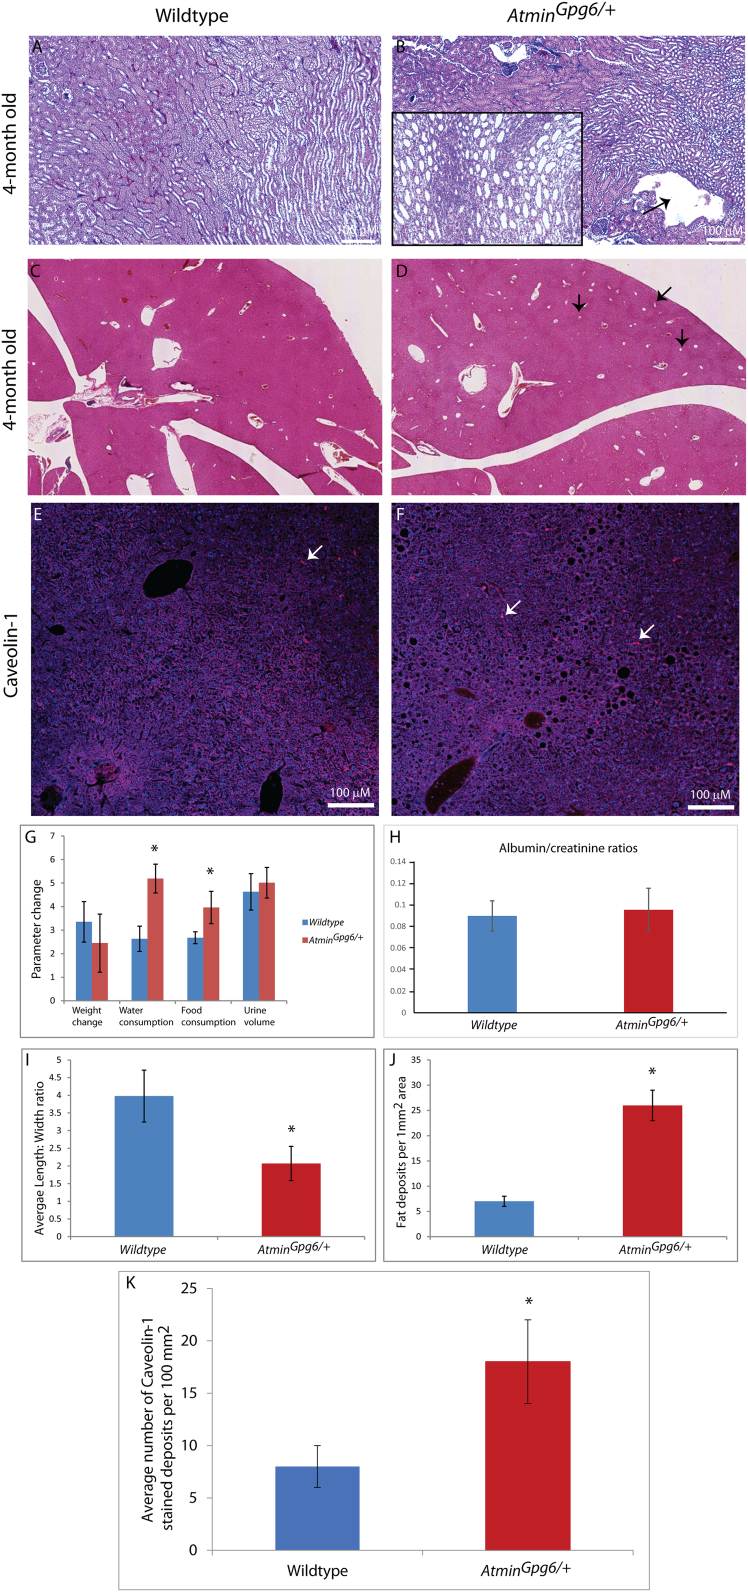
The AtminGpg6 phenotype mimics ARPKD. 4-month old AtminGpg6/+ kidneys stained with haemotoxylin and eosin showed tubule dilation (black box, B and I) and disorganised (black arrows) ureteric-bud derived structures (B) that were not observed in age-matched wildtype kidneys (A). Increased fat deposits were detected in AtminGpg6/+ livers (D, black arrows, J), a phenotype which was not seen in normal littermates (C; n = 8 per genotype). The increased number of fat deposits was confirmed by caveolin-1 staining of wildtype (white arrows, E) and AtminGpg6/+ (white arrows, F) livers, with an average of 8 vs 18 caveolin-1 stained deposits per 100 mm2 (K) being identified. Increased water and food consumption was observed in 4-month old AtminGpg6/+ mice (G, n = 12 per group, *p < 0.05) without a change in body weight or urine production or a significant difference in the albumin/creatinine ratio between AtminGpg6/+ and normal littermates (H).